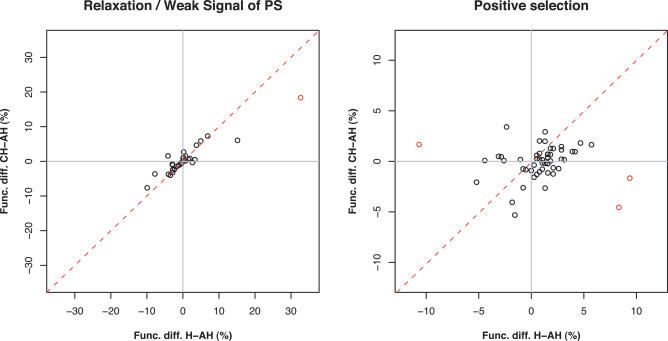
Ancestral and Derived Trends in Adaptation and RSCDifferences in GO term representation between the sets of the derived and the ancestral lineages (H-AH, human versus ancestral lineage; CH-AH, chimp versus ancestral lineage) are plotted against each other using genes exclusively observed in Test I (RSC) and Test II (PS). Each quadrant represents a particular evolutionary scenario increasing or decreasing in GO representation for each of the lineages after speciation. Terms showing a difference in representation between H-AH and CH-AH >10% were labeled in red: G-coupled protein receptor was found in both Test I (14.32%) and Test II (12.89%), and sensory perception (11.03%) and cellular protein metabolism (−12.34%) in Test II. Only the terms common to all lineages are shown.